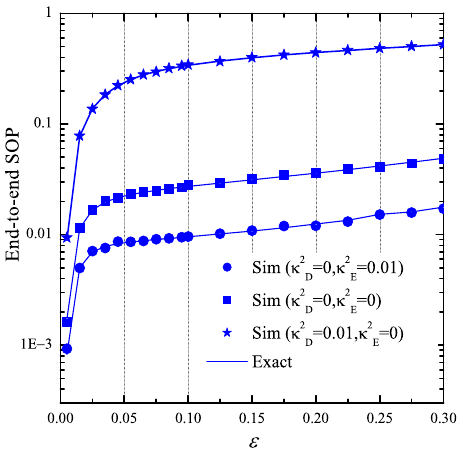
Figure 7. End-to-end secrecy outage probability as a function of ε when P S = 10 dB, K = 4, N D = 2, N E = 2, η = 0.1, C th = 0.25, x B = 0.5, y B = 0.3, x P = 0.5, y P = − 0.5, x E = 0.5, and y E = 0.5.